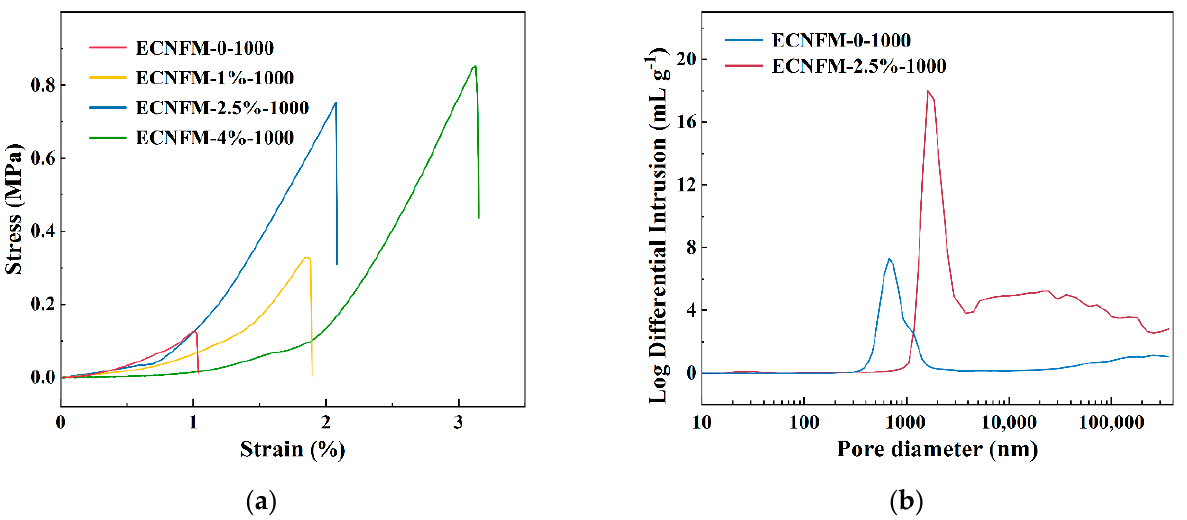
Figure 3. ( a ) Tensile stress–strain curves of ECNFM-R-1000 (R = 0, 1, 2.5, 4%); ( b ) pore distribution of ECNFM-R-1000 (R = 0, 2.5%).